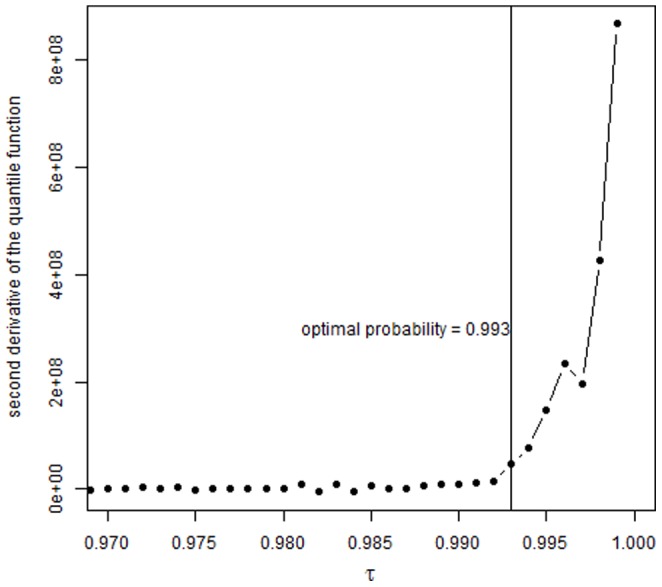
Plot showing the second derivative of the quantile function of non-zero count values.